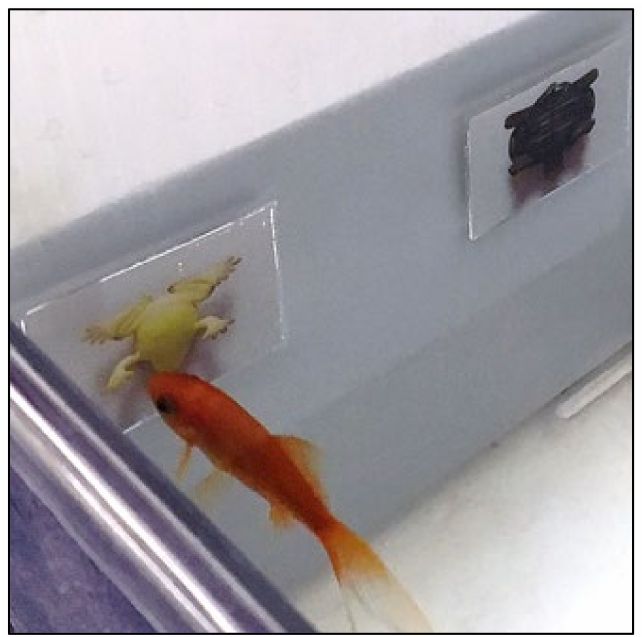
Figure 2. Photo of the experimental setup in the test tank showing a goldfish choosing the frog stimulus rotated 180 ◦ in the depth plane (rotated along the x -axis) by tapping on it. In the two-alternative forced choice task, the fish were reinforced for correct choices with food paste: a mixture of TetraFin ® flakes and water similar to [15,45,65,66]. Food paste was delivered to the fish using a 1.0 mL Luer-Lok ® tip syringe (BD, Franklin Lakes, NJ, USA), and about 0.01 mL of food paste was awarded for each correct choice. Experimenter 1 held the syringe out of sight from the fish behind the test tank wall until a correct choice was made. As soon as the subject tapped once on the reinforced stimulus (S+), experimenter 1 lowered the syringe into the tank to the top center section of the S+ stimulus card until the fish ate the food paste. If a fish tapped the incorrect stimulus (S − ), it was not reinforced, and the stimulus board was withdrawn. The fish was allowed to choose only one stimulus (S+ or S − ) for each trial. The stimulus board was always removed from the test tank during the intertrial interval of about 10–30 s when experimenter 1 recorded the data for the trial. A second experimenter stood out of the line of sight of the test tanks and recorded trial times using a stopwatch (ProCoach RS-013 Water Resistant Sports Stopwatch). Experimenter 2 started the stopwatch when experimenter 1 said “start” as the stimulus board first touched the bottom of the test tank. Experimenter 2 stopped the stopwatch when experimenter 1 said “stop” as soon as the fish tapped the stimulus for the first